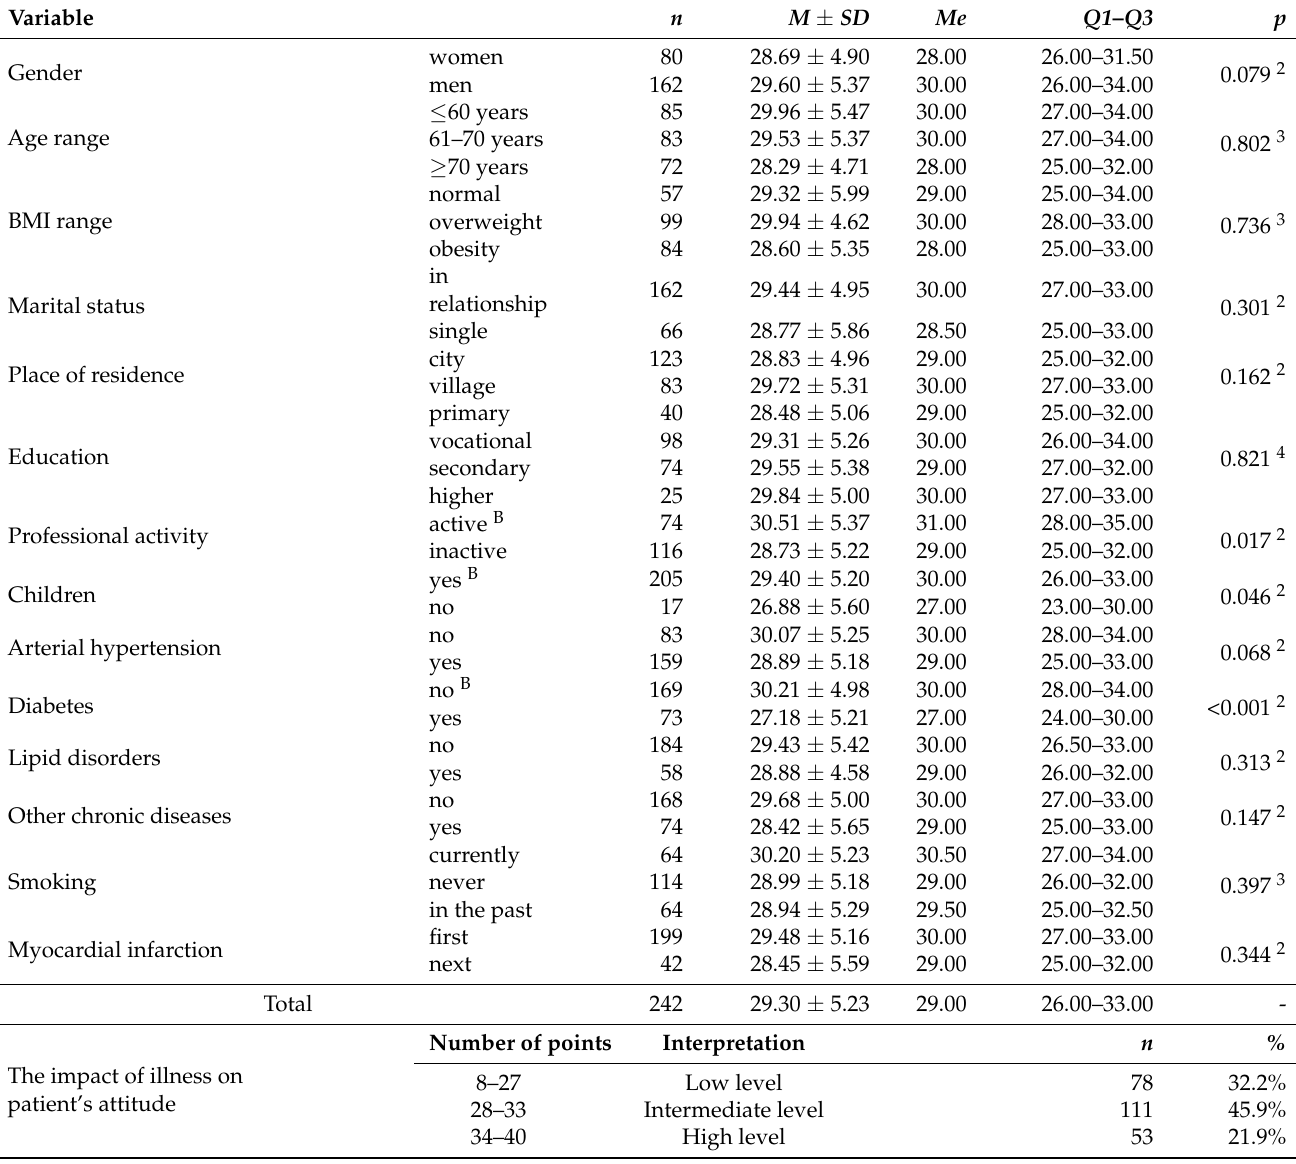
Table 5. The effect of socio-demographic and clinical variables on patient’s